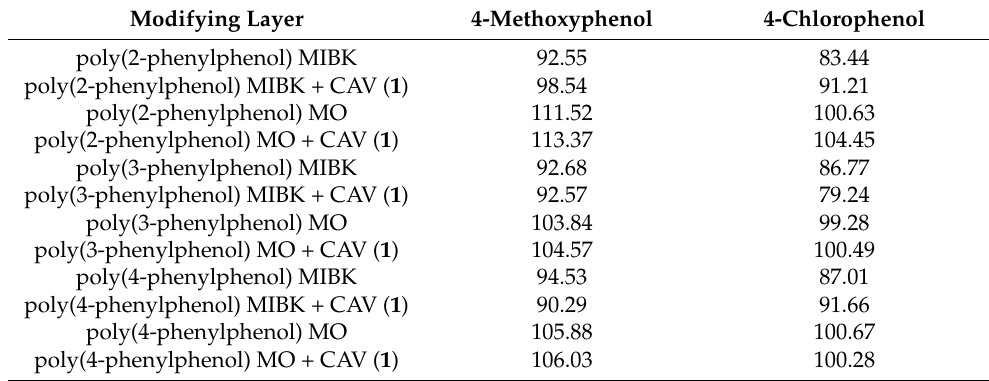
Table 1. Recoveries in % of 4-methoxyphenol and 4-chlorophenol with the electrodeposited